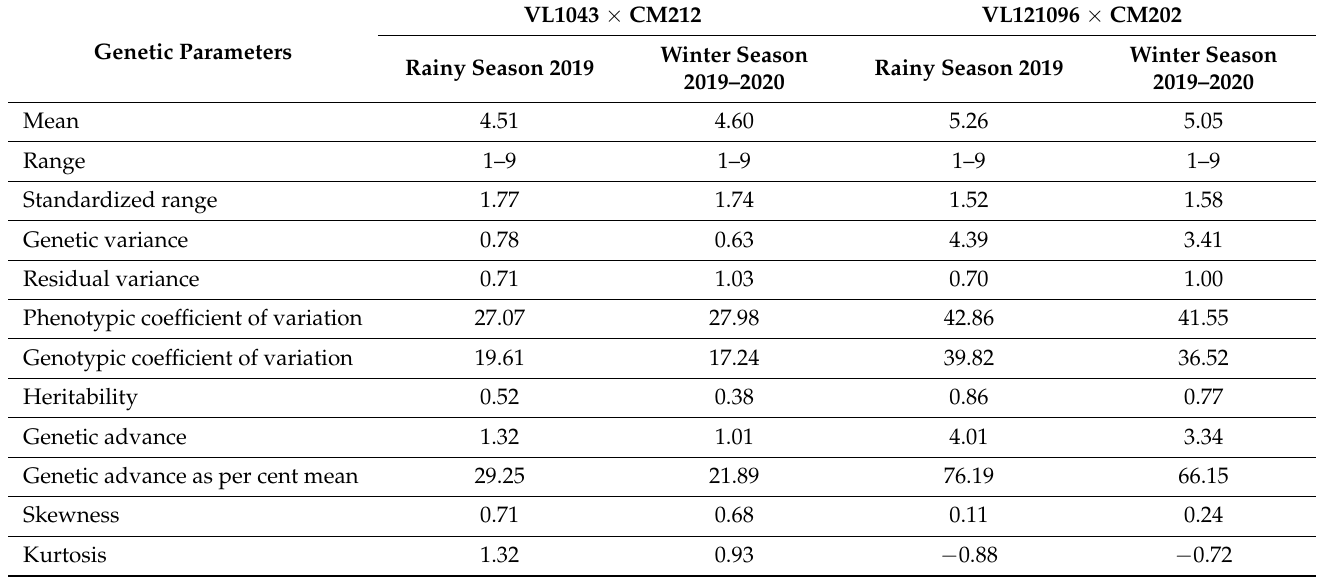
Table 6. Genetic estimates of bi-parentally derived F 2 population in reaction to FSR disease in